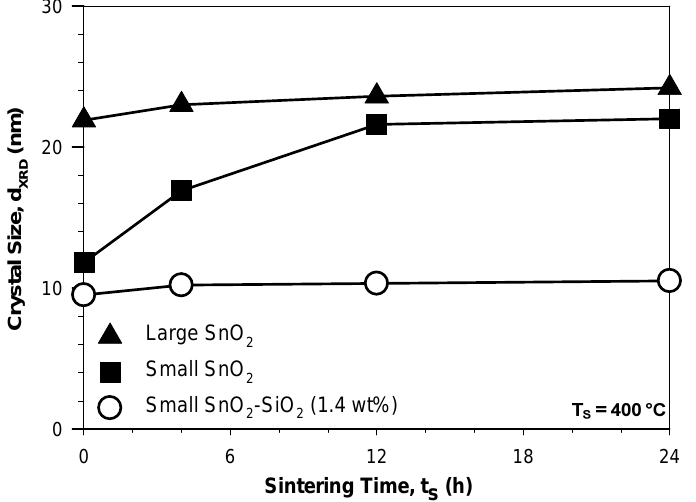
) of large (triangles) and small (squares) SnO XRD 2 2 crystals. 2